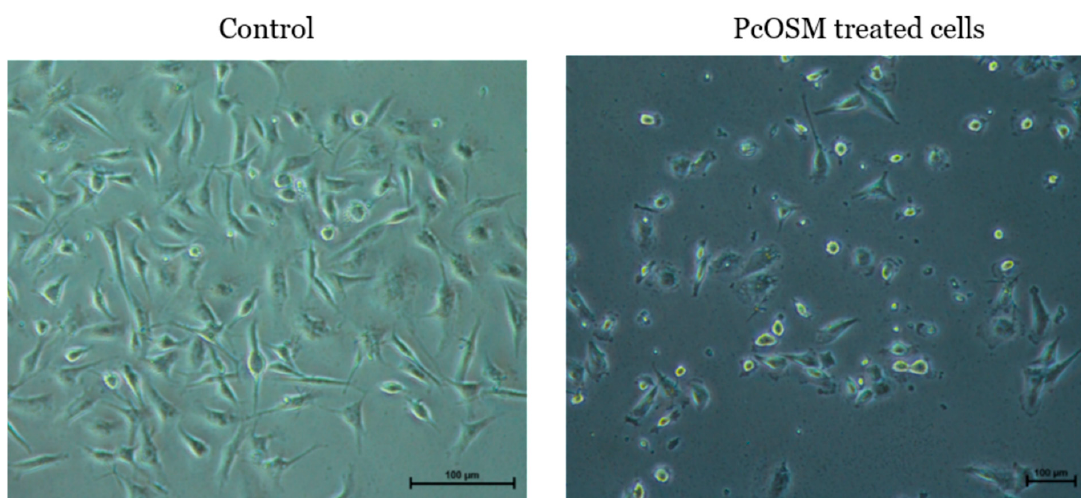
Figure 9. PcOSM induced cellular senescence in MDAMB231 cells: Senescence associated beta galactosidase assay (SA- β - Gal) staining of cells indicated concentration of PcOSM after 72 h. Cells were fixed and stained with fresh SA- β -Gal. PcOSM treated cells exhibited blue colour indicating senescent cells.